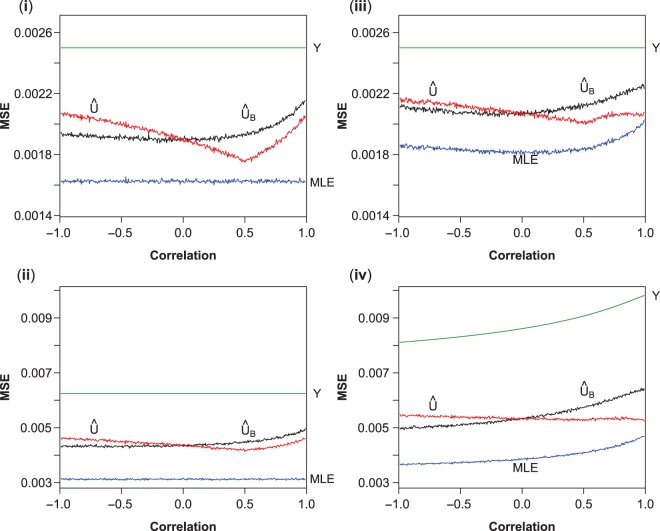
MSE of the MLE (blue), \documentclass[12pt]{minimal}
\usepackage{amsmath}
\usepackage{wasysym}
\usepackage{amsfonts}
\usepackage{amssymb}
\usepackage{amsbsy}
\usepackage{upgreek}
\usepackage{mathrsfs}
\setlength{\oddsidemargin}{-69pt}
\begin{document}
}{}$Y$\end{document} (green), \documentclass[12pt]{minimal}
\usepackage{amsmath}
\usepackage{wasysym}
\usepackage{amsfonts}
\usepackage{amssymb}
\usepackage{amsbsy}
\usepackage{upgreek}
\usepackage{mathrsfs}
\setlength{\oddsidemargin}{-69pt}
\begin{document}
}{}$\hat {U}_B$\end{document} (black), and \documentclass[12pt]{minimal}
\usepackage{amsmath}
\usepackage{wasysym}
\usepackage{amsfonts}
\usepackage{amssymb}
\usepackage{amsbsy}
\usepackage{upgreek}
\usepackage{mathrsfs}
\setlength{\oddsidemargin}{-69pt}
\begin{document}
}{}$\hat {U}$\end{document} (red). Plots show the mean of 100 000 simulations for each value of \documentclass[12pt]{minimal}
\usepackage{amsmath}
\usepackage{wasysym}
\usepackage{amsfonts}
\usepackage{amssymb}
\usepackage{amsbsy}
\usepackage{upgreek}
\usepackage{mathrsfs}
\setlength{\oddsidemargin}{-69pt}
\begin{document}
}{}$\rho $\end{document}, except for \documentclass[12pt]{minimal}
\usepackage{amsmath}
\usepackage{wasysym}
\usepackage{amsfonts}
\usepackage{amssymb}
\usepackage{amsbsy}
\usepackage{upgreek}
\usepackage{mathrsfs}
\setlength{\oddsidemargin}{-69pt}
\begin{document}
}{}$Y$\end{document}, which is the theoretical value of the MSE.